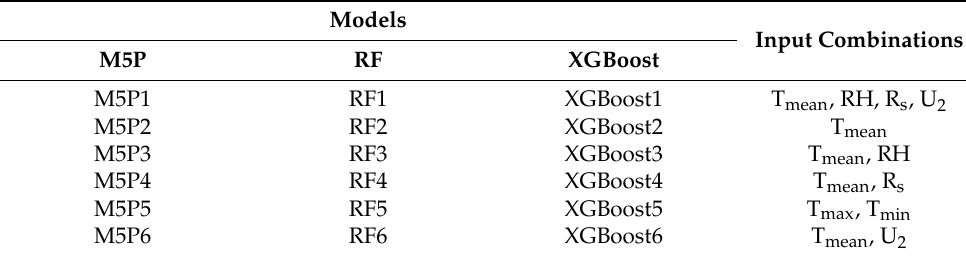
Table 1. The input combinations of meteorological variables for various machine learning models.